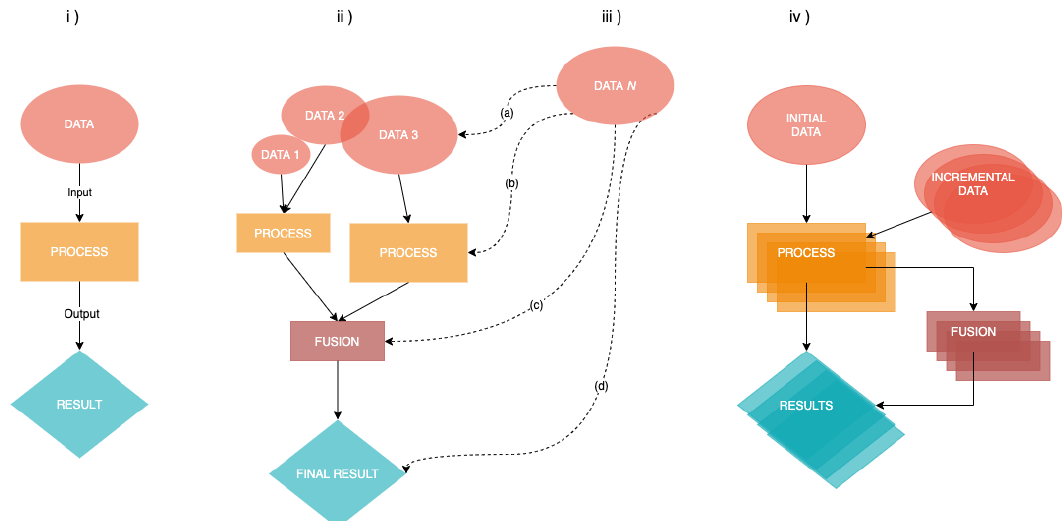
Figure 1. Diagram synthesizing CH oriented multimodal IBM workflows; conventional “one-shot” application ( i ), current state ( ii ) and issues ( iii ) and targeted approach ( iv ) using